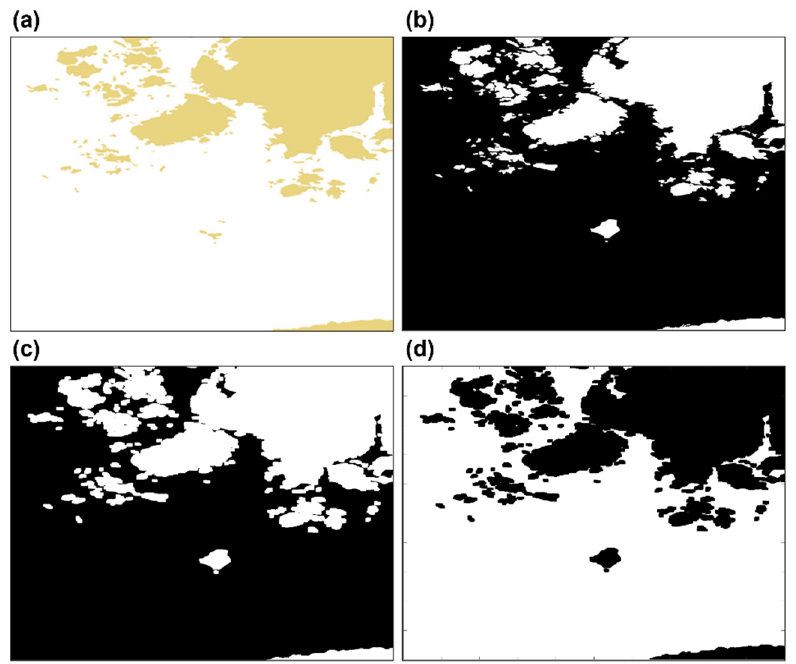
Figure 16. Building a map for generating the initial route: ( a ) Original chart image, ( b ) binary image map with safety depth data ( c ) applied safety margin ( d ) binary occupancy grid map for route search.